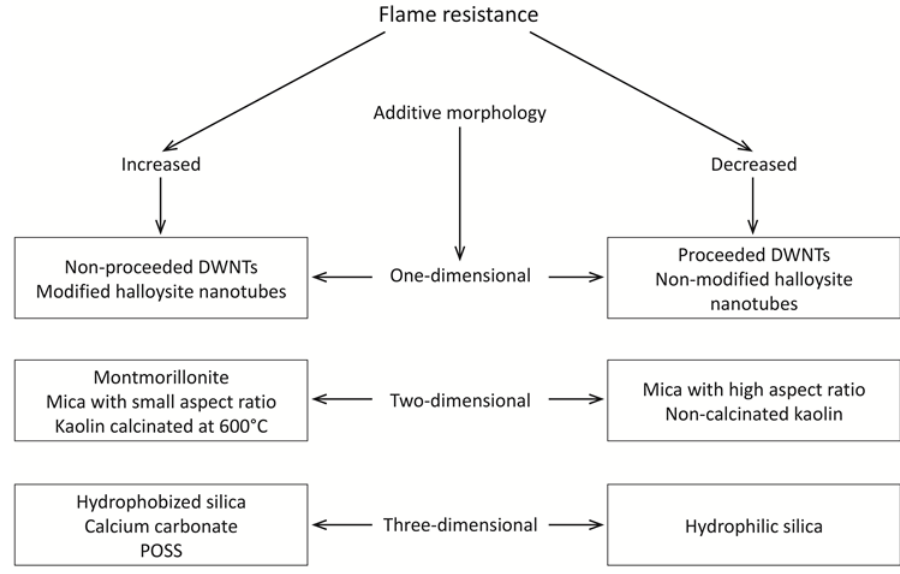
ff ect of the additive morphology on the flame resistance of PDMS Figure 2. The effect of the additive morphology on the flame resistance of PDMS composites. Figure 2. The e